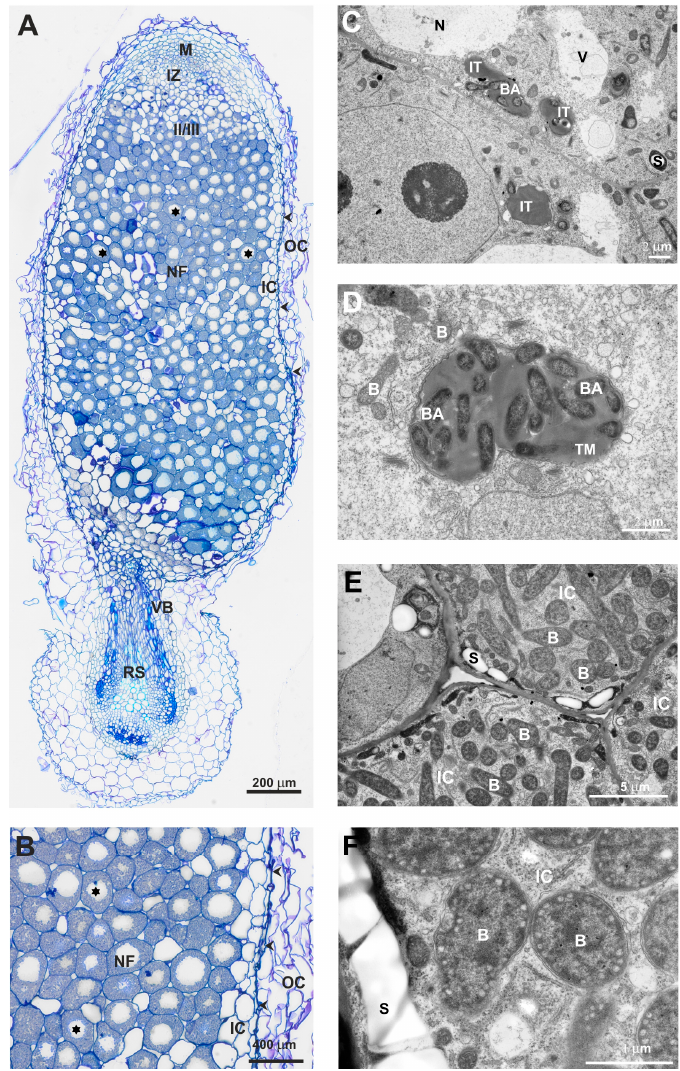
Figure 13. Semi-thin section of a 21-dpi clover root nodule elicited by the wild-type strain R. leguminosarum Rt24.2 ( A ), OC: outer cortex; IC: inner cortex; RS: root stela; VB: nodule vascular bundle; M: meristem; IZ: infection zone; II/III: interzone; NF: nitrogen fixation zone; black asterisks: infected cells; arrowheads: nodule endodermis. ( B ), nitrogen fixation zone with mature infected plant cells; NF: nitrogen fixation zone; OC: outer cortex; IC: inner cortex; black asterisks: infected cells; arrowheads: nodule endodermis. ( C , D ), Ultrastructure of an infection thread (IT) containing Rt24.2 cells; TM: thread matrix; BA: bacteria; B: bacteroids; S: starch granules. ( E , F ), Mature infected cells; IC: infected cell; B: bacteroids; S: starch